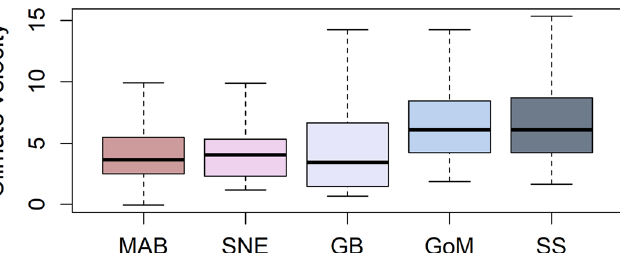
Figure 3. Median climate velocity (km/year) within the Mid-Atlantic Bight (MAB), Southern New England (SNE), Georges Bank (GB) and Gulf of Maine (GOM) subregions of the Northeast US, as well as the Scotian Shelf (SS) in